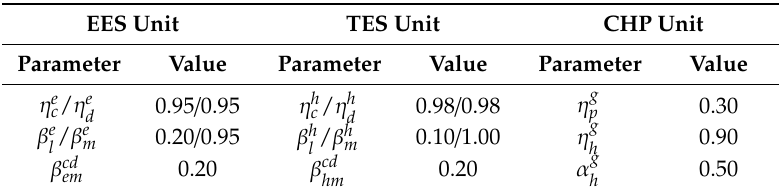
Table 1. Parameters of System